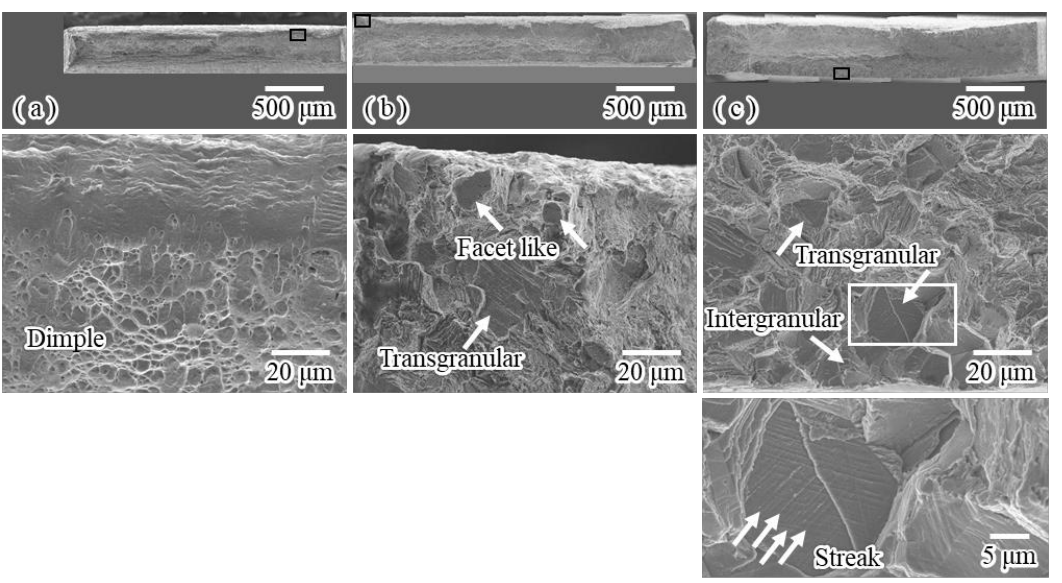
Figure 10. SEM images of general and magnified views of representative fracture surfaces of specimens subjected to tensile fracture at 25 °C after tensile straining to 0.2 at −196 °C; ( a ) uncharged specimen, ( b ) conventionally charged specimen and ( c ) specimen charged by modified method.